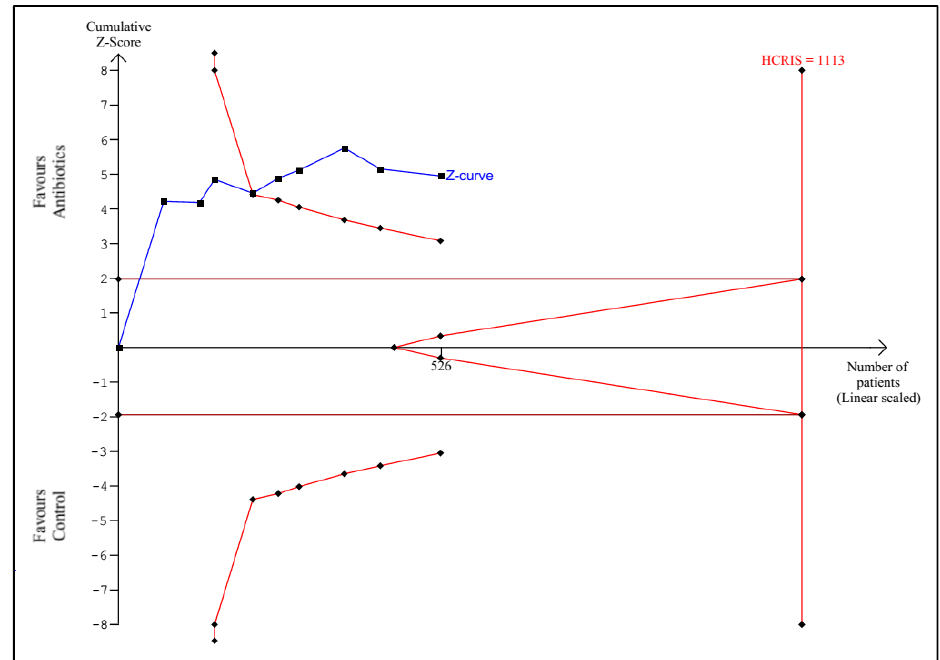
Figure 5. Trial sequential analysis for all infectious complications. The Z-curve crossed both the conventional and constructed monitoring boundaries at a total of 526 randomized patients (47% of the HCRIS) with an HCRIS of 1113 patients calculated based on a 40% incidence of infections in the control group, an RRR of 30%, an alpha of 5%, a beta of 20%, and heterogeneity of 56%; HCRIS = heterogeneity-corrected required information size.